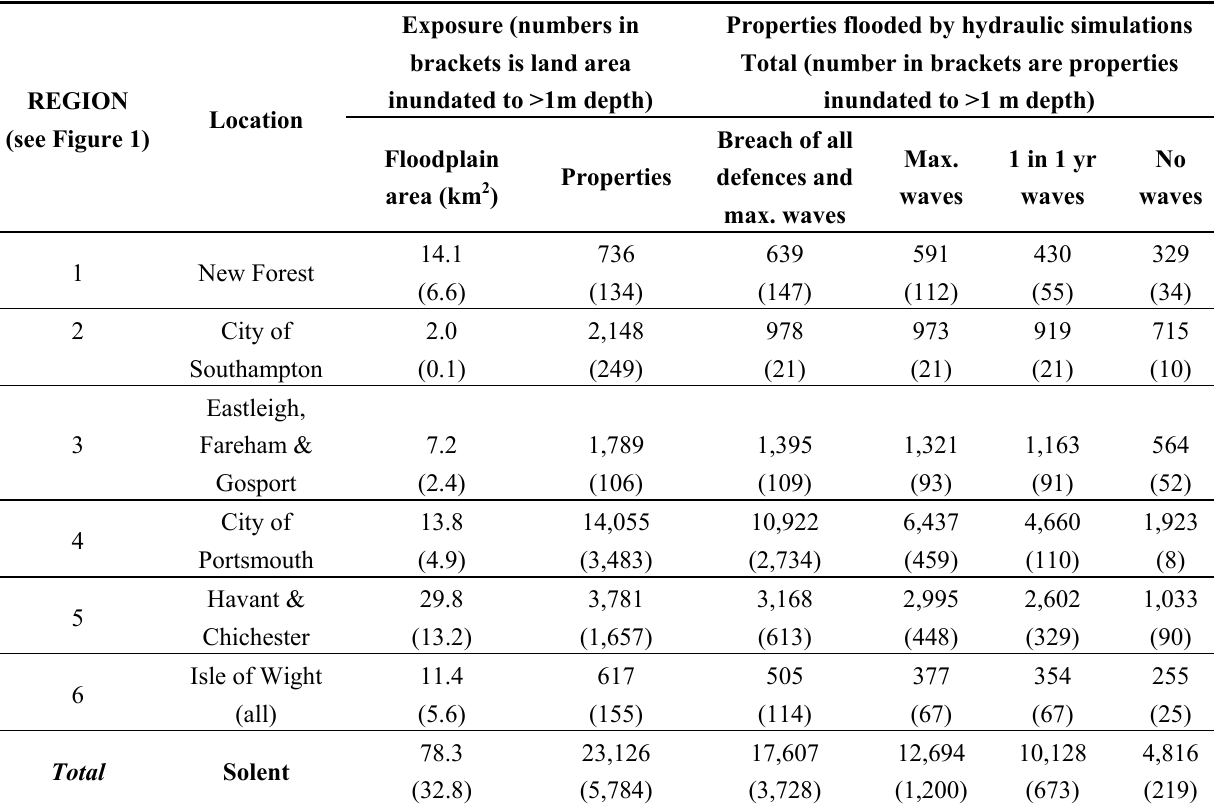
Table 4. Modelling results for a 1 in 200 year water level coastal flood in the Solent (refer to Figure 1 for